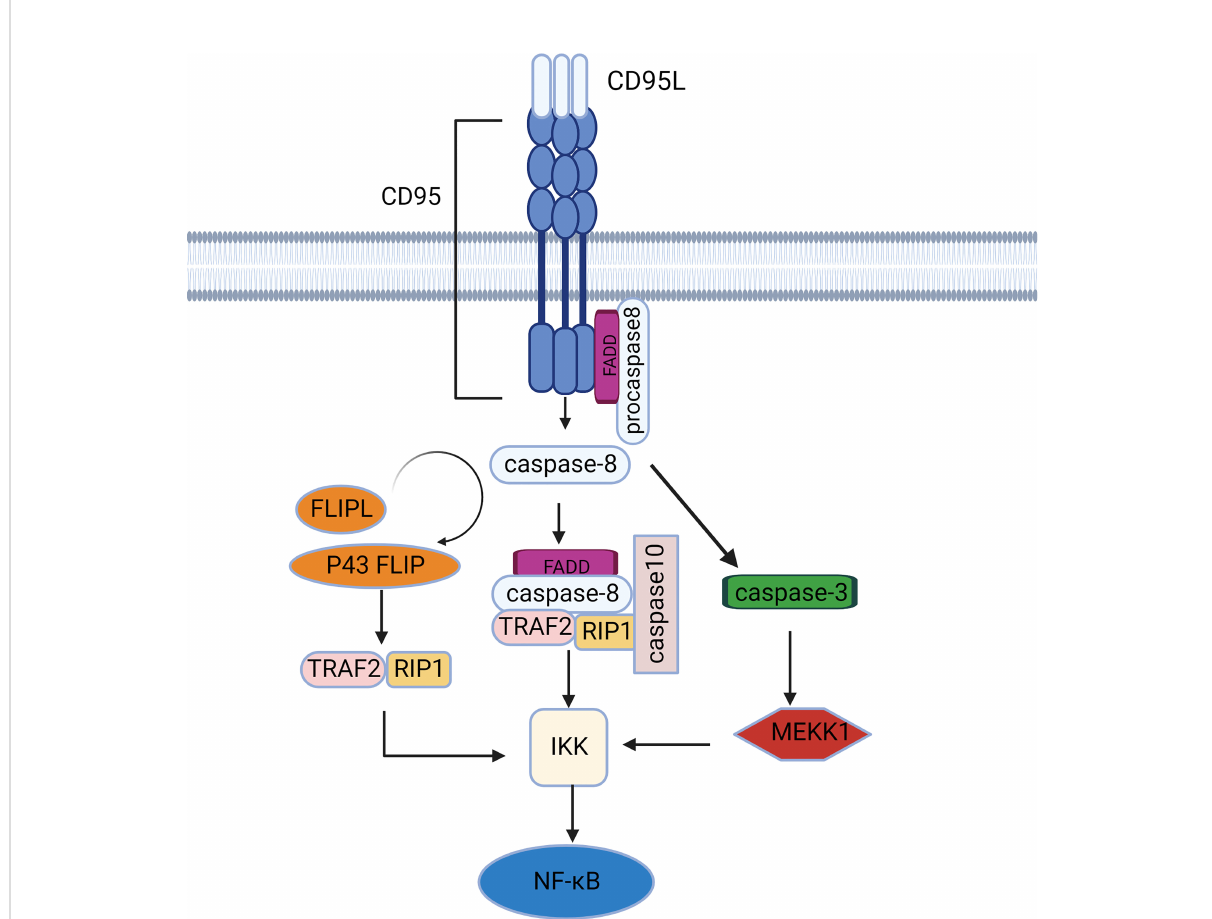
FIGURE 2 The NF- k B signaling pathway mediated by CD95. CD95 induces caspase-dependent activation of the NF- k B pathway via IKK activation. There are 2 major IKK activation pathways: the RIP1/TRAF2-dependent pathway and the MEKK1 activation